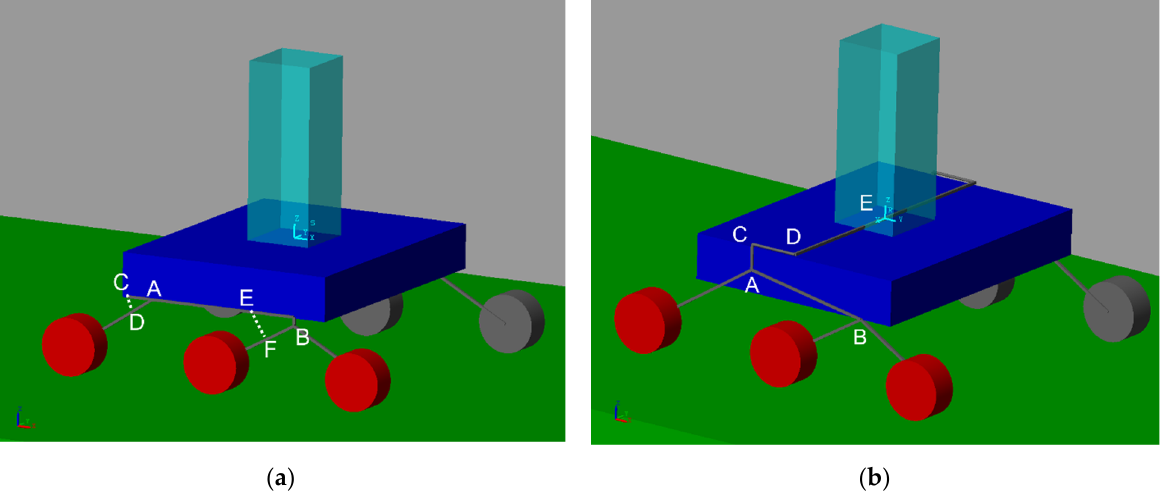
Figure 2. Rover vehicle structures used in this paper: the linear suspension rover (LSR) ( a ) equipped with two independent spring–damper suspension systems; ( b ) the rocker-bogie rover (RBR), which employs an articulated suspension system similar to the rover used for Mars exploration.